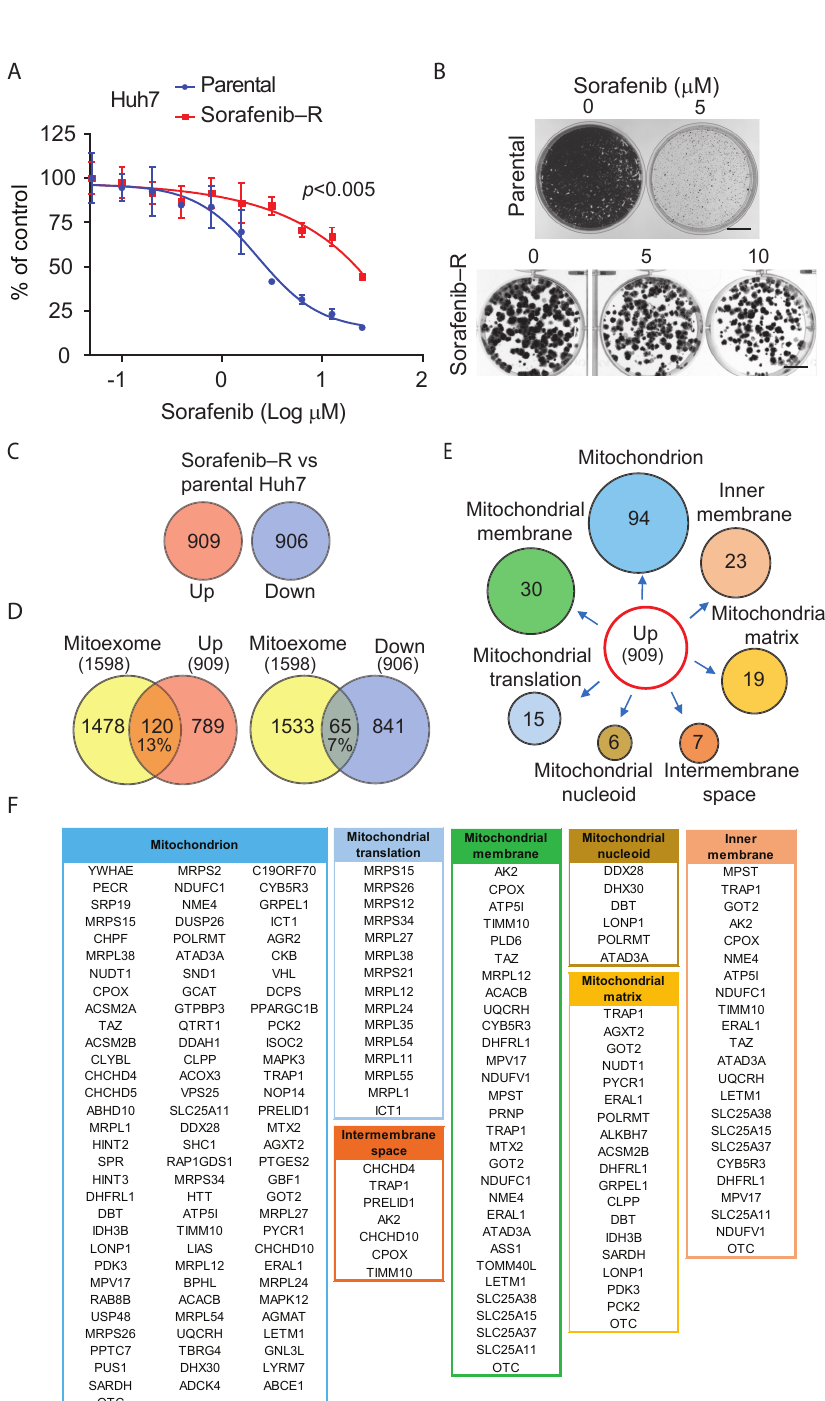
Figure 1. Extensive transcriptional and mitochondrial reprogramming in sorafenib-resistant hepa- tocarcinoma cells. ( A ) Proliferation of parental and sorafenib-resistant (sorafenib-R) Huh7 cells in the presence of sorafenib. Cell viability was measured after 72 h with the MTT assay. Sorafenib-R cells were generated by 3-month continuous growth with sorafenib. ( B ) Growth of parental (top) and sorafenib-resistant (bottom) Huh7 cells exposed to sorafenib. Sorafenib-R cells were generated after 3-weeks of continuous exposure to sorafenib in clonal growth conditions. Bar, 10 mm. ( C ) Genes up- and downregulated in sorafenib-resistant Huh7 cells compared to parental cells. ( D ) Overlap of genes up- and downregulated in sorafenib-resistant Huh7 cells with the human mitoexome. ( E ) Numbers and functional classes of mitochondrial genes upregulated in sorafenib-resistant Huh7 cells. ( F ) Mitochondrial genes upregulated genes in sorafenib-resistant Huh7